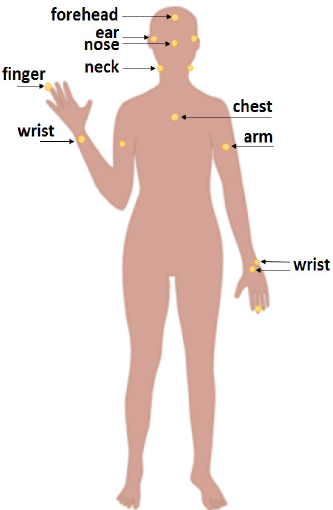
Figure 1. The PPG signals are recorded from various body positions using a custom device. For the wrist, three positions are considered such as the wrist-end of the ulna bone, and the centre of the wrist (front and rear positions).